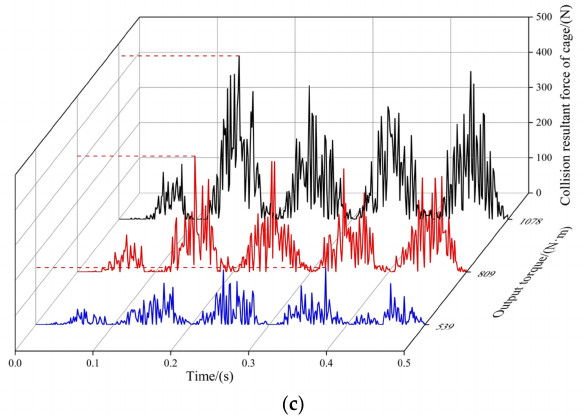
Figure 11. The resultant force of the collision between the roller and the cage under different working conditions. ( a ) cp = 0.2 mm. ( b ) cp = 0.3 mm. ( c ) cp = 0.4 mm. Table 2. The maximum collision force of the cage. Pocket Clearance of